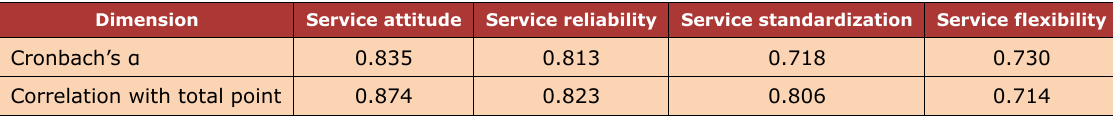
Table 4. Results of reliability and validity test